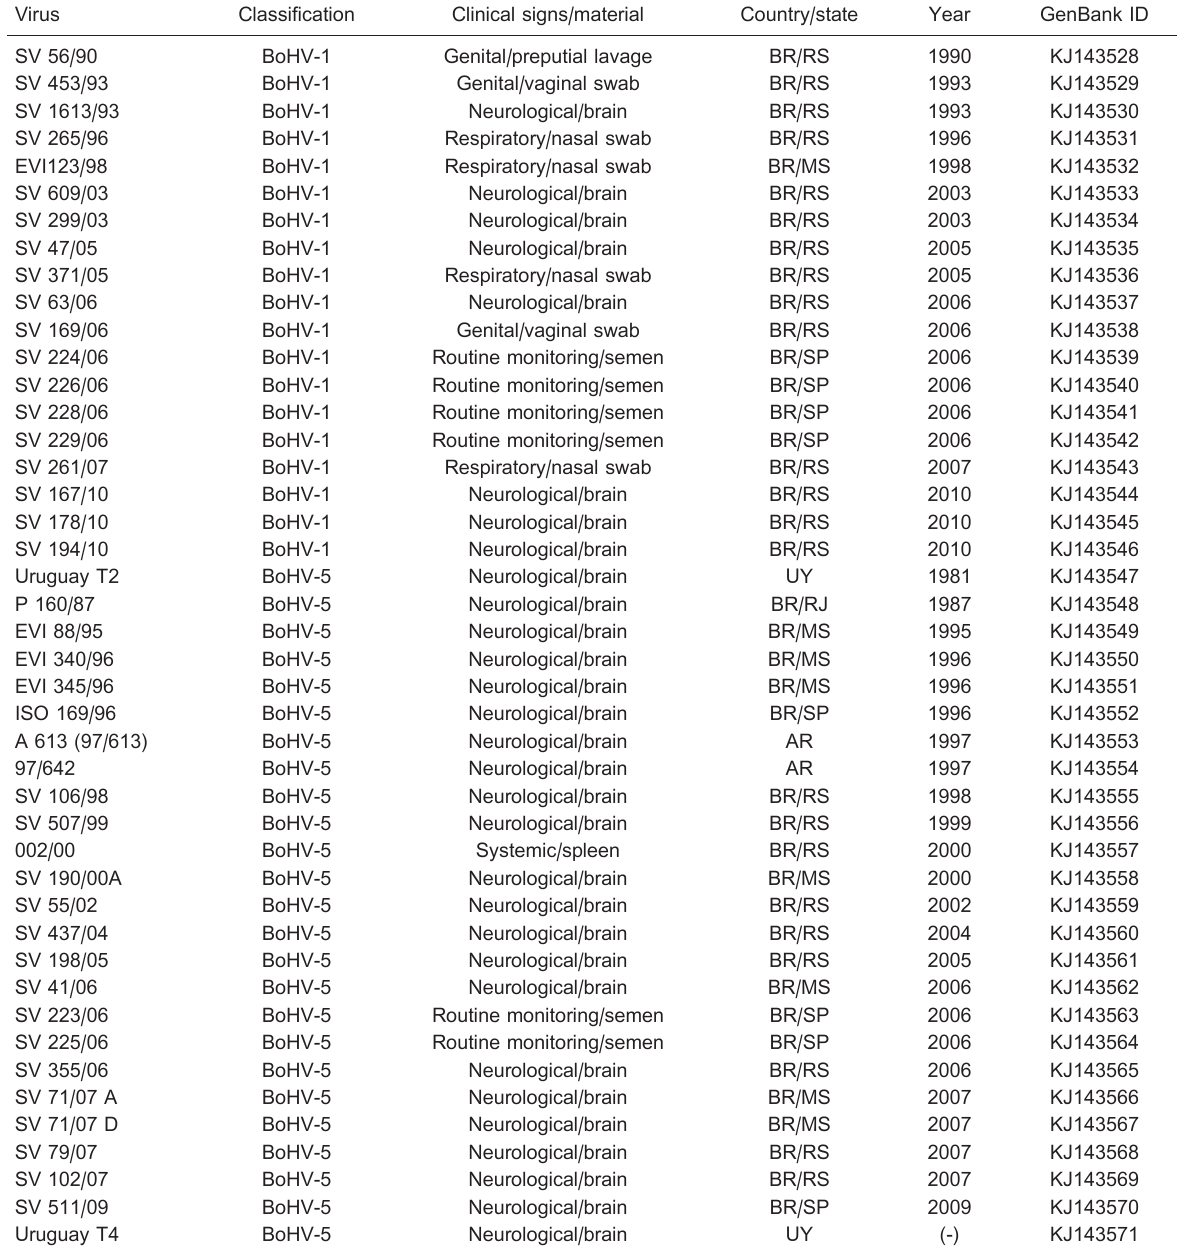
Table 1. Bovine herpesvirus type 1 (BoHV-1) and BoHV-5 isolates from Brazil (BR), Uruguay (UY), Argentina (AR), and reference strains included in the present study.